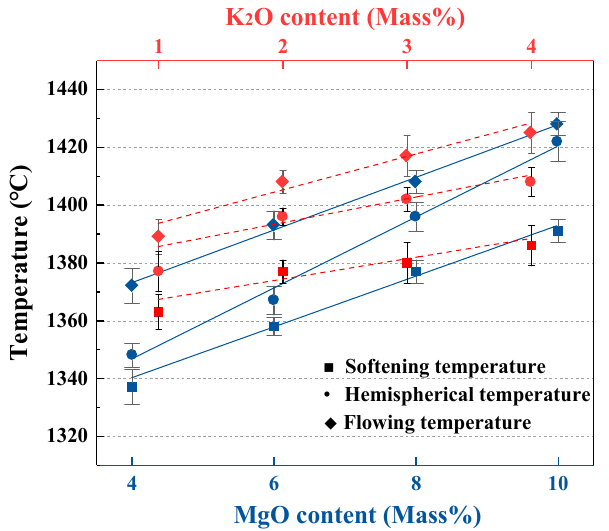
Figure 9. The fractions of the different types of oxygens ( a ) with a varying MgO content; and ( b ) with a varying K 2 O content.